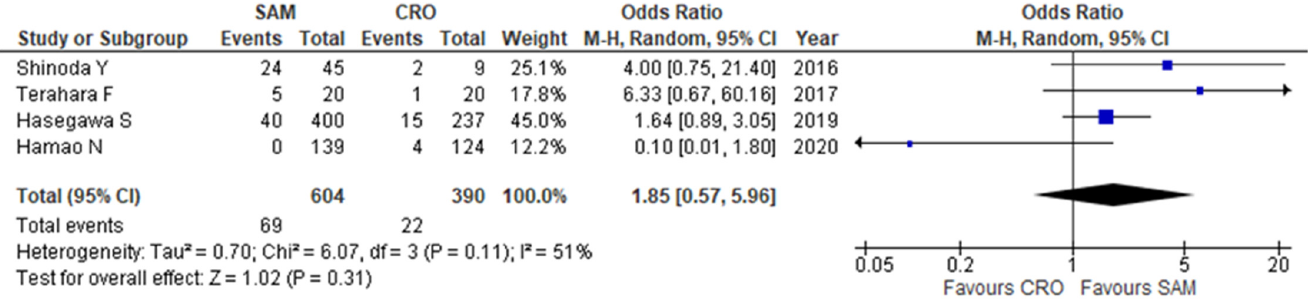
Figure 2. Forest plot presenting the odds ratios for mortality in patients treated with sulbactam- ampicillin and those treated with ceftriaxone in community-acquired pneumonia. CI, confidence interval; CRO, ceftriaxone; M - H, Mantel - Haenszel; SAM, sulbactam-ampicillin; blue square, OR of each study; Black rhombus, pooled OR.